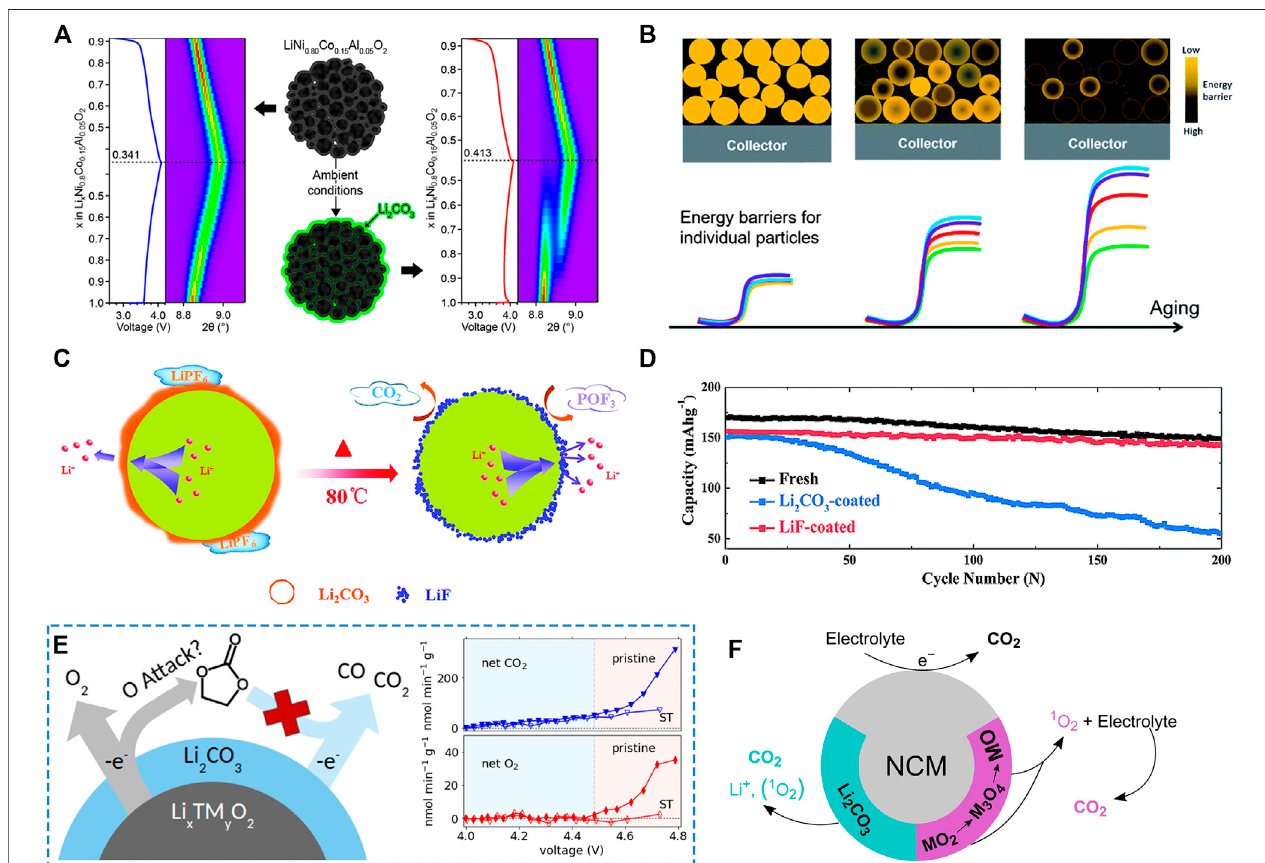
FIGURE 2 | (A) The splitting of the (003) re fl ection of LiNi 0.8 Co 0.15 Al 0.05 O 2 after air exposure. Adapted from [Grenier et al., 2017] with permission from American Chemical Society. (B) Schematic diagram of the energy barrier evolution with aging; the different colors of the lines represent different energy barriers from different particles. Adapted from [Qian et al., 2019] with permission from Royal Society of Chemistry. (C) Scheme illustration of the surface reaction of Li 2 CO 3 -coated material in LiPF 6 electrolyte and (D) Cyclic stability of fresh, Li 2 O coated, LiF coated NCM811 at 1 C. Adapted from [Bi et al., 2016] with permission from Royal Society of Chemistry. (E) Gas evolution (O 2 and CO 2 ) for pristine (untreated) and surface treated (ST) 18O-NMC, showing attenuation of both the CO 2 and O 2 evolution rates after removal of a portion of Li 2 CO 3 . Adapted from [Renfrew and McCloskey, 2017] with permission from American Chemical Society.) (F) Scheme illustration of the origin of